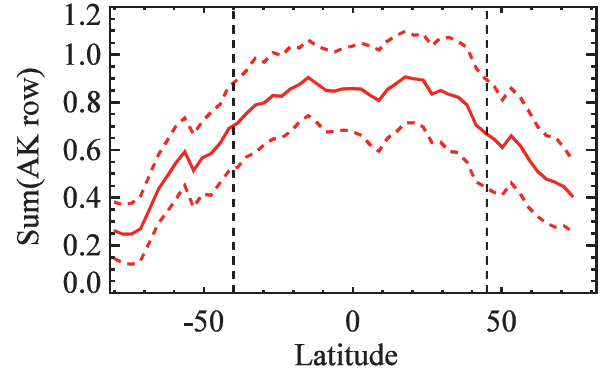
Fig. 4. Averaging kernel rows for an average of ocean (near Mauna Loa, left) and land (near the SGP site, right) targets over a 4-year period. The ocean targets show more sensitivity on average because the mean tropical ocean temperature is 300K versus 290K for the land cases, leading to a higher thermal contrast. Therefore, although daytime, summer, land targets will have the greatest sensitivity, av- eraging over winter and night reduces land average sensitivity.